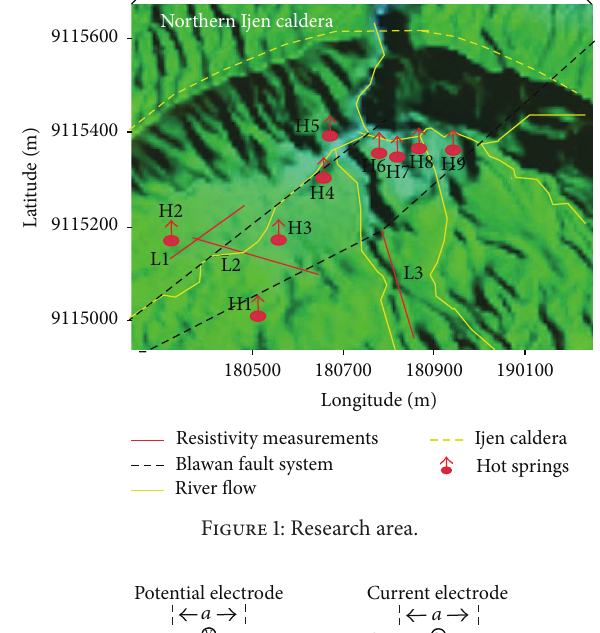
Pseudosection plot point